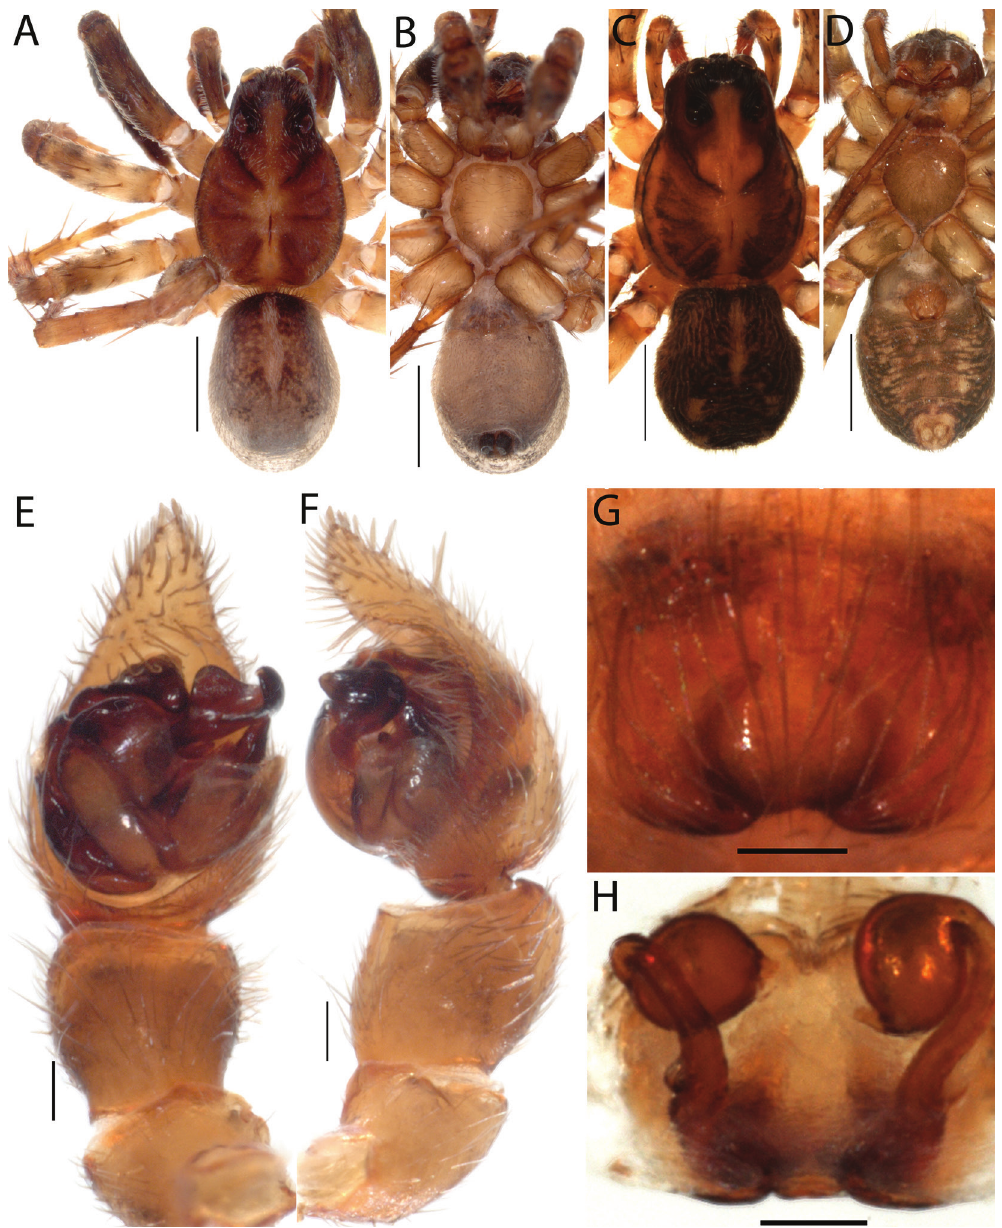
Figure 24. A helensmithae sp. n. , male holotype (AM KS128076), female paratype (AM KS61928): A , male habitus, dorsal view; B , male habitus, ventral view; C , female habitus, dorsal view; D , female habitus, ventral view; E, male pedipalp, ventral view; F , male pedipalp, retrolateral view; G , epigyne, ventral view; H , epigyne, dorsal view. Scale bars: habitus 1.0 mm; pedipalp, epigyne 0.1